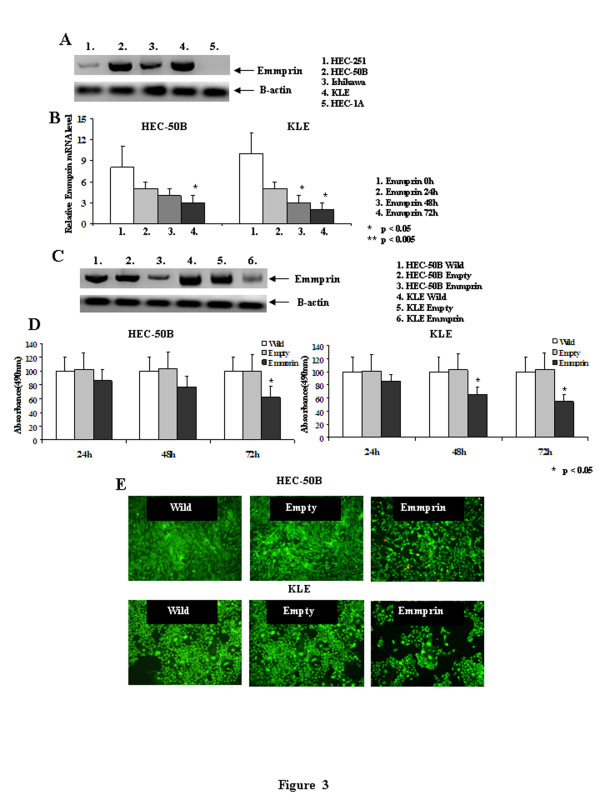
Emmprin expression in endometrial cancer and real-time PCR, western blot, MTS assays and Cell viabilities of HEC-50B and KLE cells after transfection with the emmprin siRNA. A) Western blot analysis of emmprin expression in endometrial cancer cell lines (KLE, Ishikawa, HEC-251, HEC-1A and HEC-50B). An anti-β-actin antibody was used after transfection with the emmprin siRNA. B) Real-time PCR of emmprin expression after transfection of the emmprin siRNA into HEC-50B and KLE cells for 24, 48 and 72 h. C) Western blot analysis of emmprin expression after transfection of the emmprin siRNA into HEC-50B and KLE cells for 72 h. An anti-β-actin antibody was used as a loading control in the same membrane. D) MTS assays of the cell proliferation of HEC-50B and KLE cells after transfection with the emmprin siRNA for 24, 48 and 72 h. The assays were carried out for quadruplicate transfection experiments. E) Cell viabilities of HEC-50B and KLE cells after transfection with the emmprin siRNA for 72 h evaluated by fluorescence microscopy.